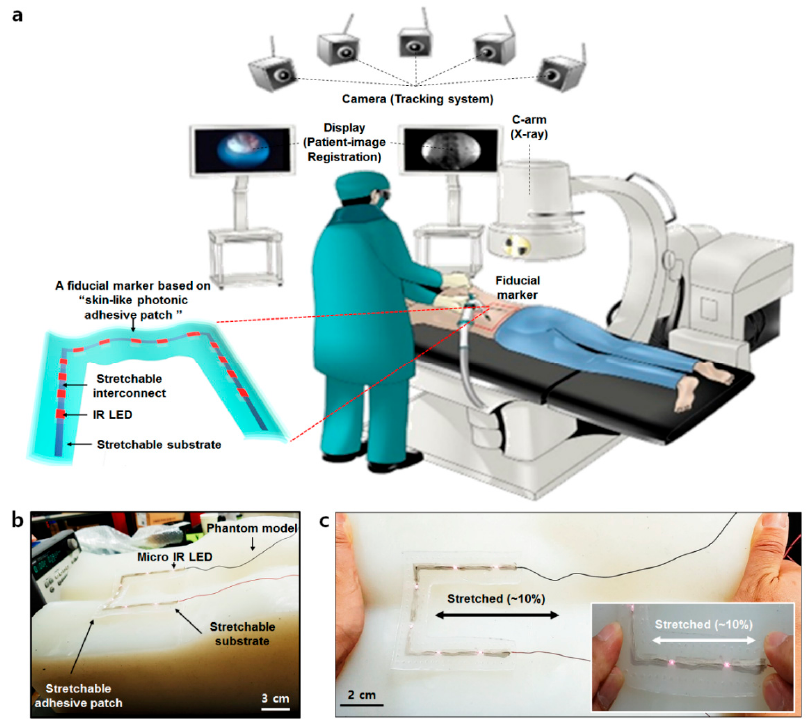
Figure 1. Schematic of a surgery navigation system and skin-conformal fiducial marker patch. ( a ) Schematic of an overall surgery navigation system and its components. ( b ) The components of the fiducial marker patch. ( c ) The stretchability of the fiducial marker patch.